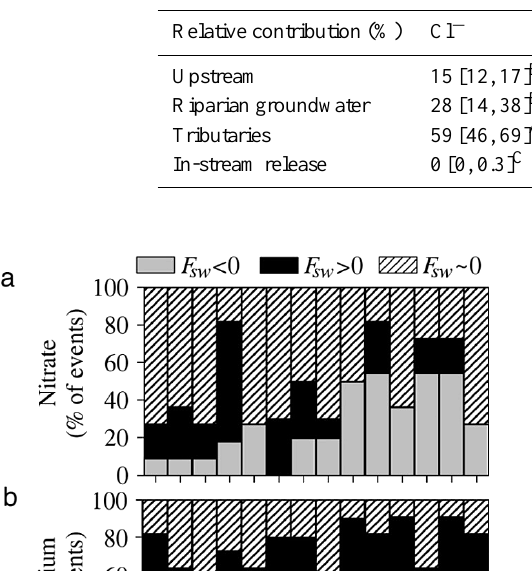
Table 4. Median and interquartile range [25th, 75th percentile] of the relative contribution of inputs from upstream ( F top /F in ) , net riparian groundwater ( (cid:0) F gw > 0 (cid:1) /F in ), tributaries ( F ef /F in ), and in-stream release ( (F sw < 0 )/F in ) to stream solute fluxes at the whole-reach scale. Note that relative contributions from different sources do not add up to 100% because they are medians rather than means. For each solute, different letters indicate statistically significant differences between sources (Mann–Whitney test with post hoc Tukey test, p < 0 . 01). n = 10 for the four solutes.